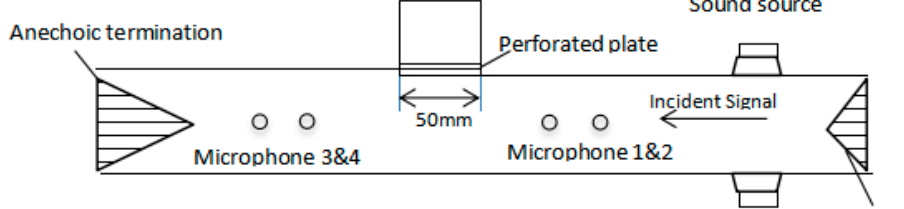
Figure 2. Experimental test rig setup.